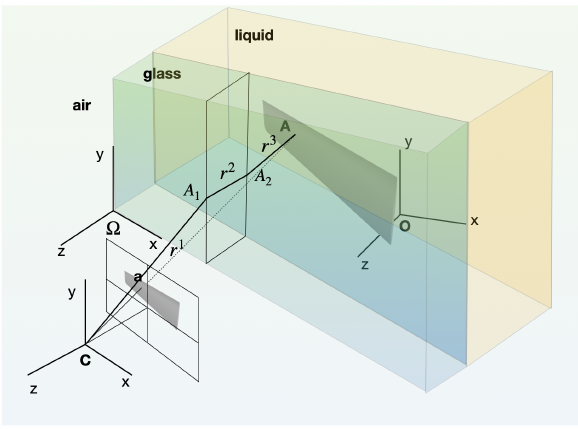
Figure 3. Systems of coordinates and the path of light